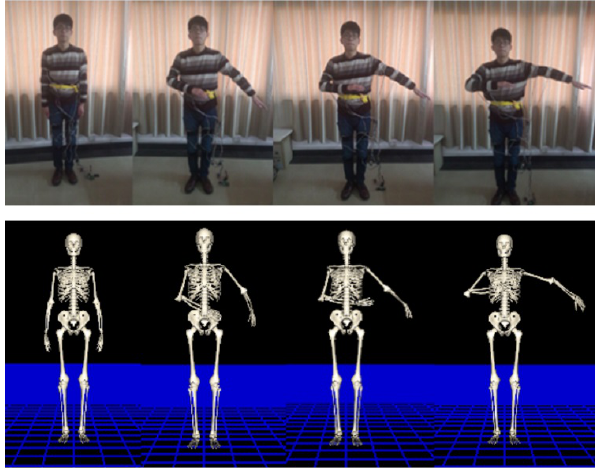
Fig. 6 Human motion gait modelling and tracking